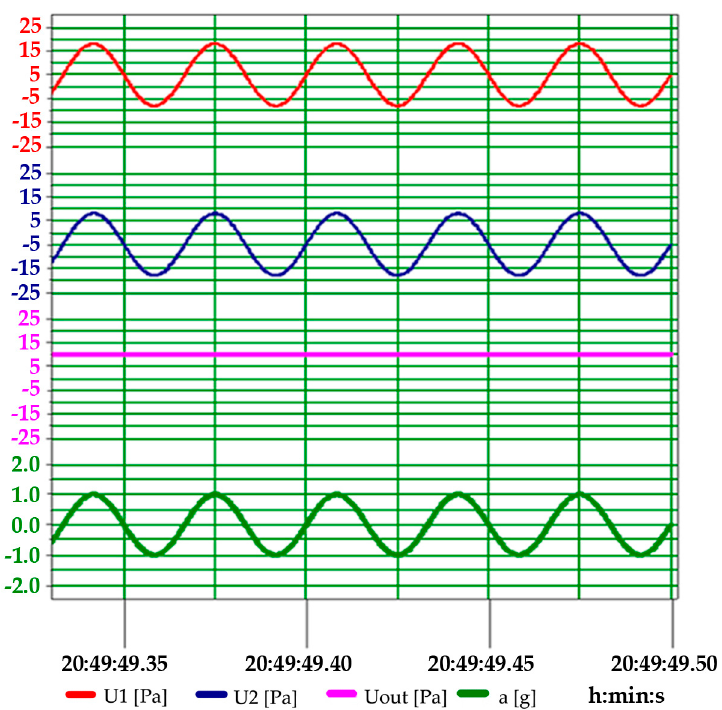
Figure 15. Waveforms of the experimental values of acceleration (a), pressure (p), and output signals (U 1 ; U 2 ; U out ) for dynamic acceleration with vibrations and with amplitude of 1 g, frequency of f = 30 Hz, and pressure excitation of p = 10 Pa for double-membrane transducer.